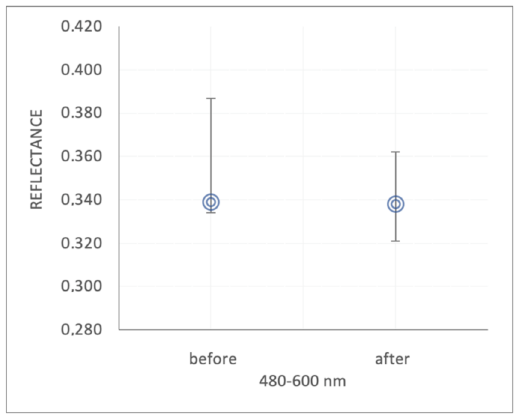
Figure 6. Median and quartile range of reflectance at the wavelength of 480–600 nm in the group of women undergoing microdermabrasion, before and after the procedure.